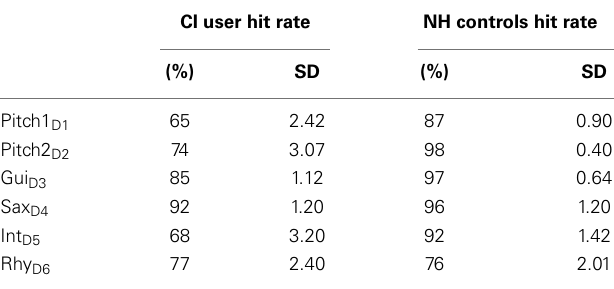
Table 3 | Hit rates of CI users and NH controls .